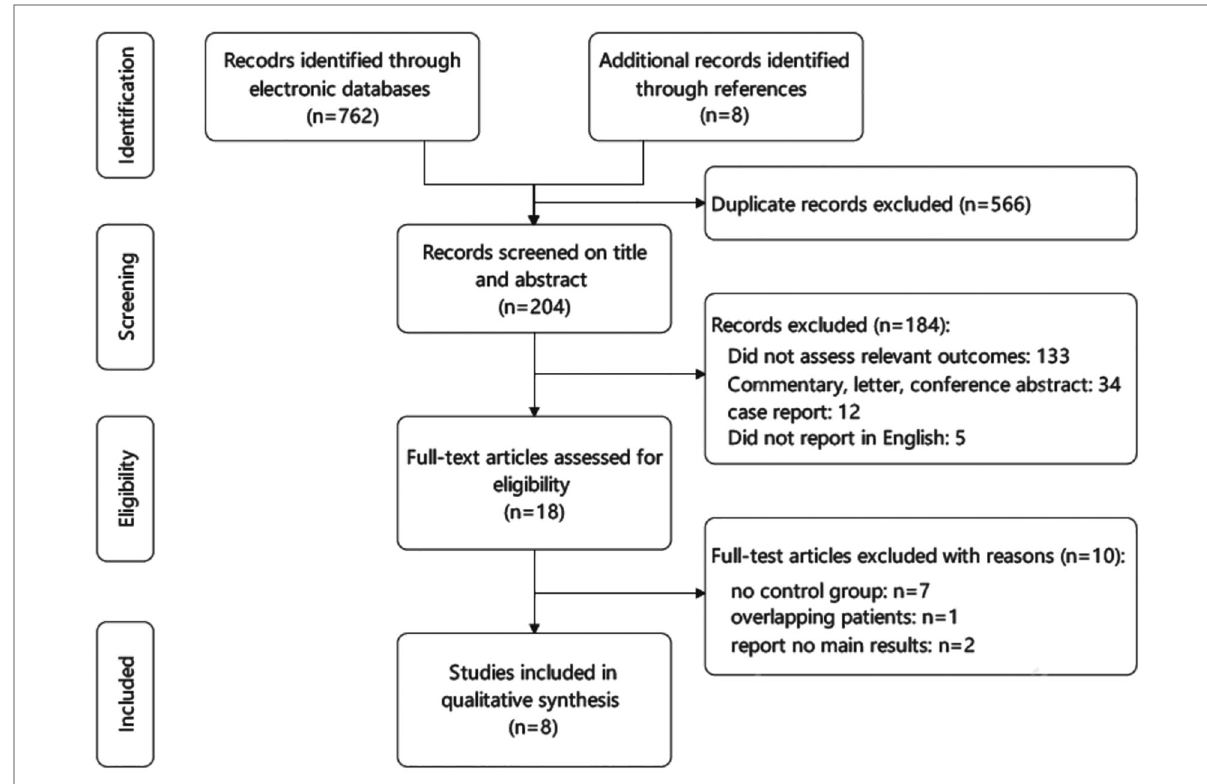
FIGURE 1 Preferred Reporting Items for Systematic Reviews and Meta-Analyses fl ow